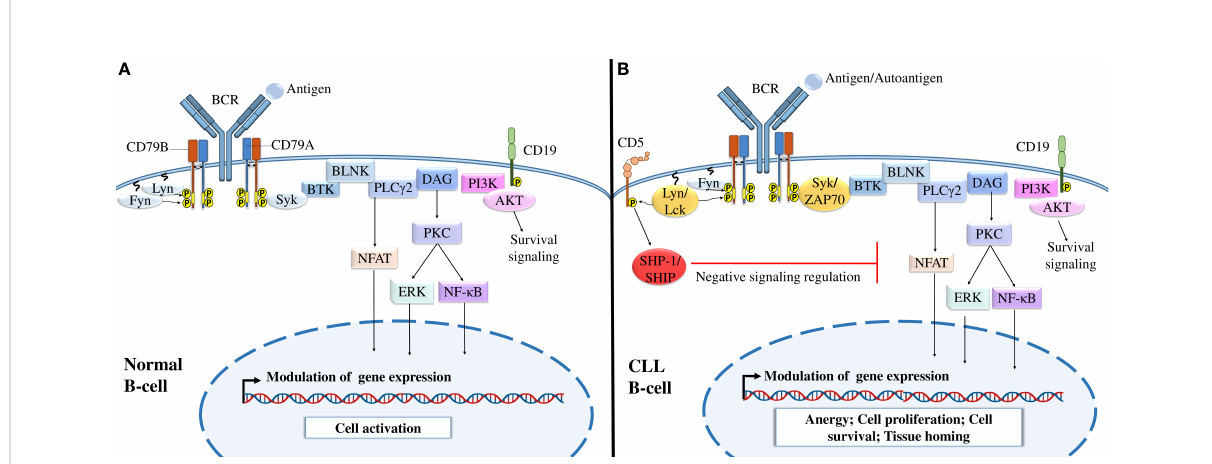
FIGURE 2 B-cell receptor signaling in normal B cells and CLL cells. (A) BCR signaling in normal B cells. The interaction of normal B lymphocyte BCRs with antigens induces the tyrosine phosphorylation of ITAMs by Src-family kinases such as Syk, Fyn, and Lyn, activating different downstream signaling pathways, including the PI3K/Akt, NFAT, NF- k B, and MAPK signaling pathways, which modulate gene expression and activate B cells. (B) BCR signaling in CLL B cells. After the interaction of CLL BCRs with antigens or autoantigens, Src-family kinases, such as Lck and ZAP-70 kinases, enhance the activation of different downstream signaling pathways necessary for B-cell survival. Malignant B cells also express CD5, which, upon activation by Lyn kinase recruits SHP-1 or SHIP to dephosphorylate signaling molecules and maintain B-cell anergy. Adapted from (36,